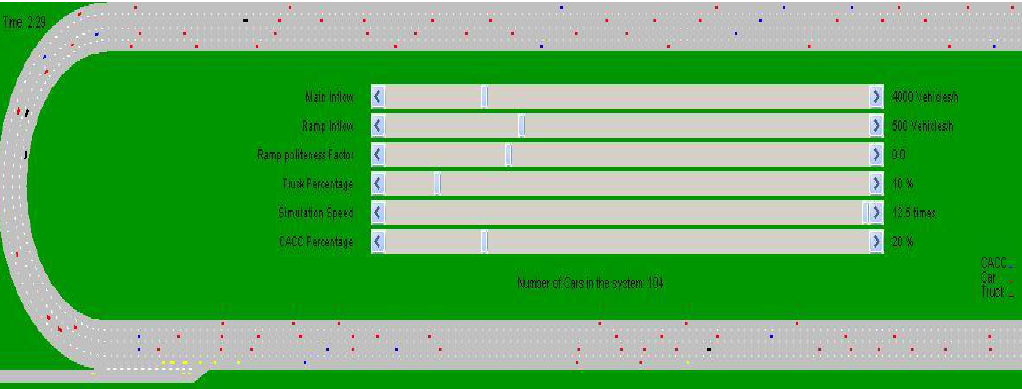
Figure 2. Snapshot of the simulation model